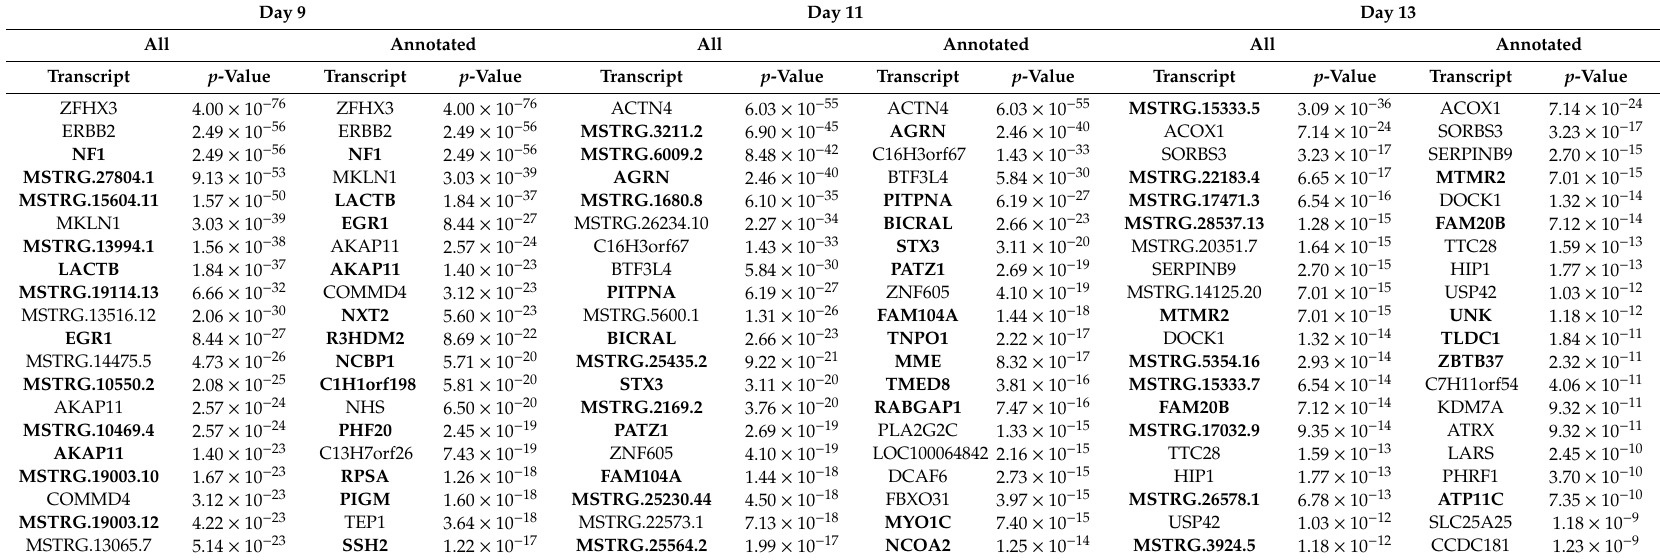
Table 2. Top 20 transcripts ranked by significance for each day in equine endometrium among samples from pregnant and non-pregnant